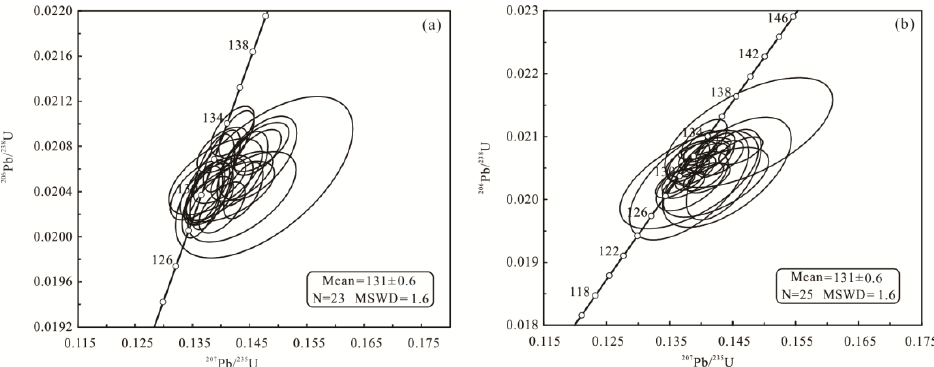
Figure 6. U–Pb Concordia diagram for the Leimengou granite porphyry zircons ( a ) and monzonitic granite porphyry zircons ( b ).